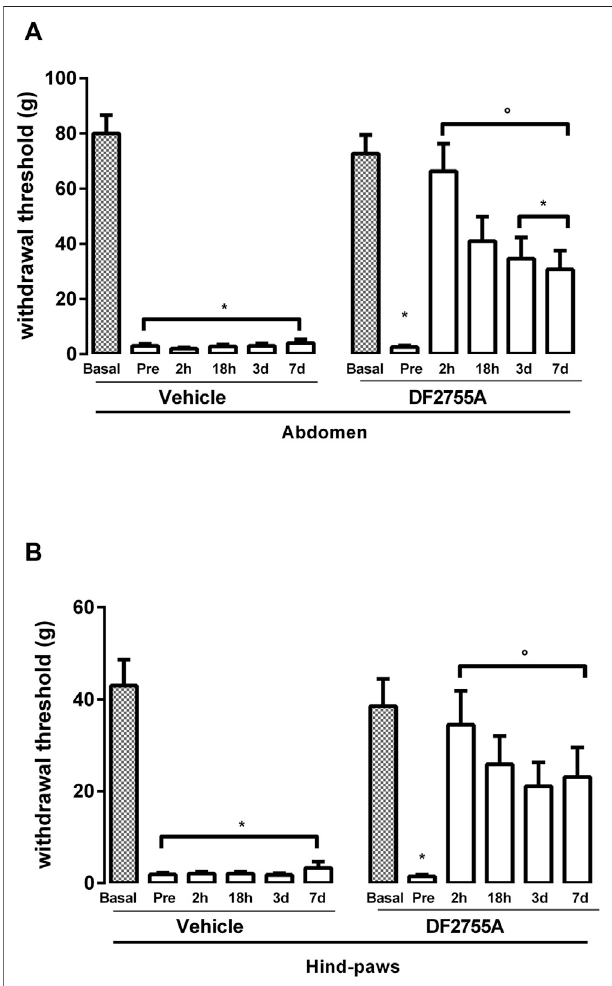
FIGURE 4 | Long-lasting ef fi cacy of DF2755A in reversing peripheral neuropathy in experimental non-Hunner IC. Animals were orally treated with repeated vehicle or DF2755A (7 mg kg − 1 twice daily for 7 days) administrations starting from 24 h after the last CYP injection. Mechanicalnociceptivethresholdwasmeasuredontheabdominalarea (A) or hind paw surfaces (B) before the fi rst CYP injection (basal), after the last CYP injection and before vehicle or DF2755A treatment (pre), and 2 h (2 h), 18 h (18 h), 3, and 7 days after the last vehicle or DF2755A treatment. Data represent the withdrawal threshold and are expressed as mean values ±SEM ( n = 10 per group). * p < 0.05 versus basal values; ° p < 0.05 versus pre- treatment values (two-way ANOVA with Tukey ’ s